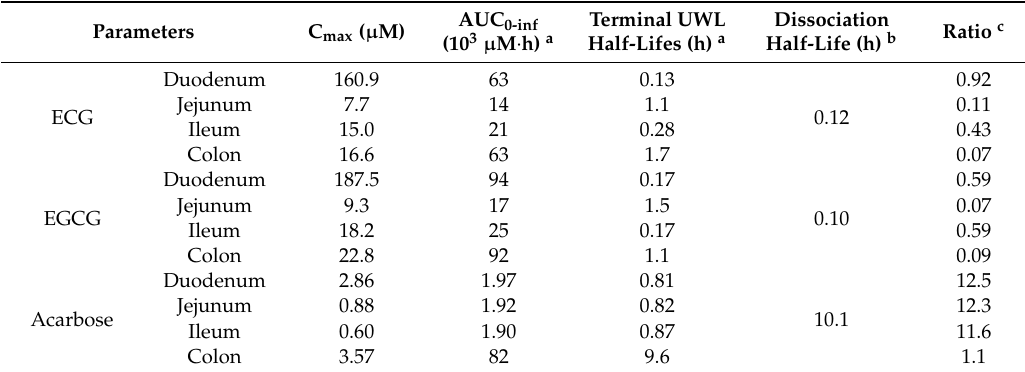
Table 2. The micro-pharmacokinetics data and dissociation half-lives for ECG and